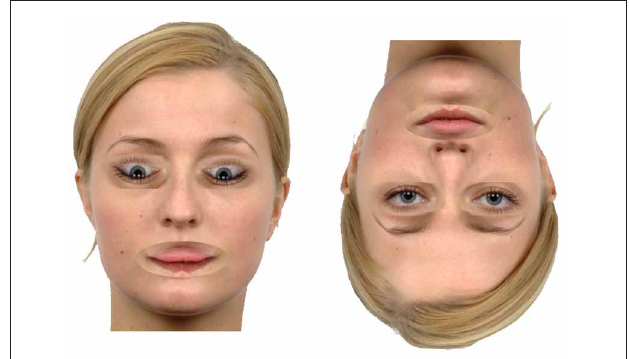
FIGURE 4 | The Thatcher illusion. Both faces have the eyes and mouth rotated “in place,” however, only the upright face appears grotesque. Unedited face not shown (Langner et al.,